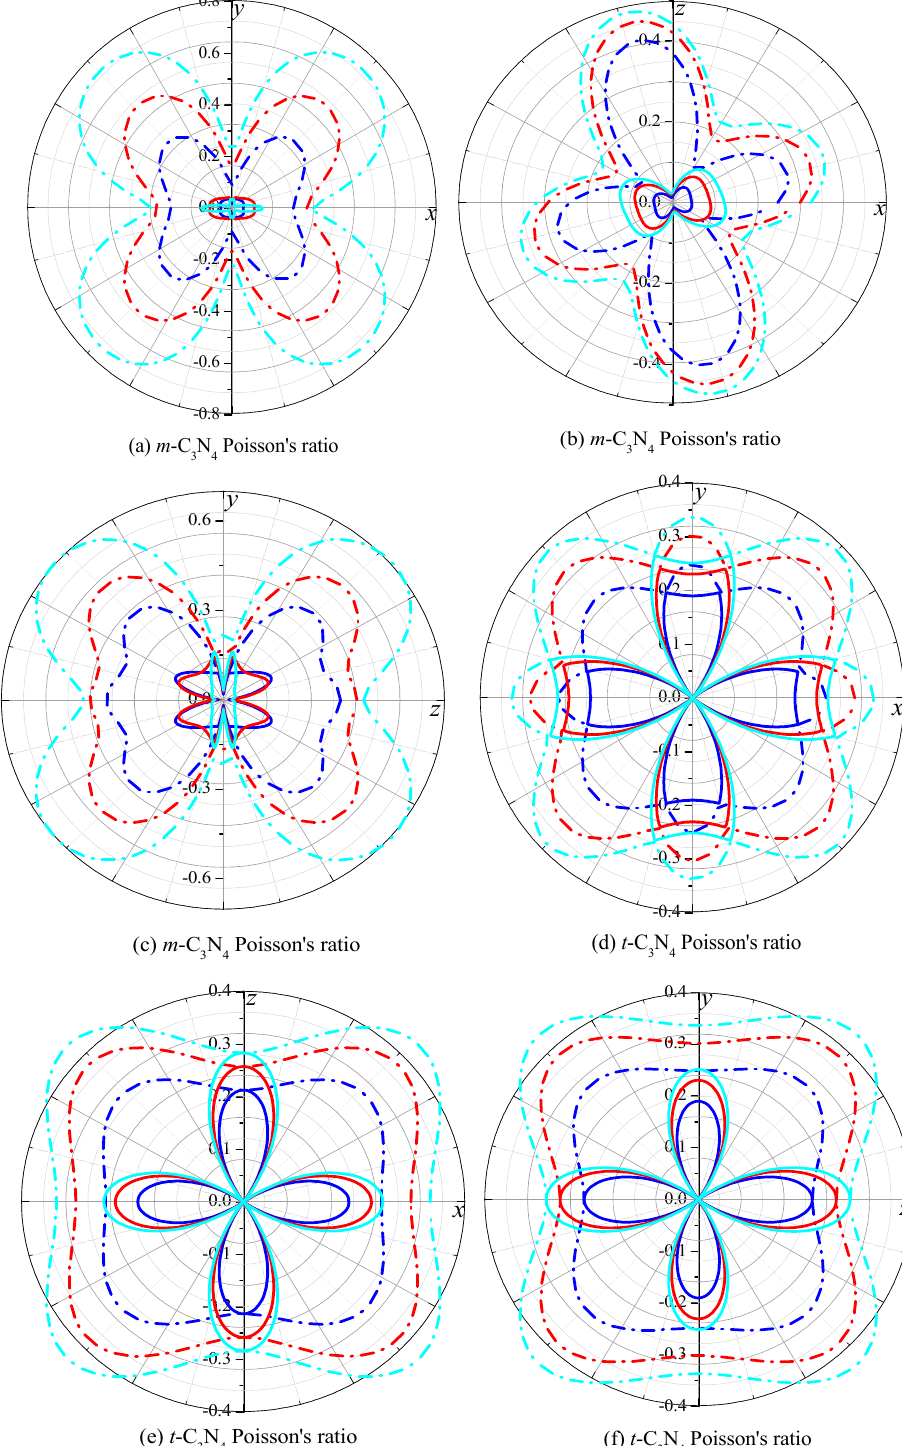
Figure 6. 2D representation of Poisson’s ratio in the xy plane, xz plane and yz plane for: m -C 3 N 4 ( a – c ); and t -C 3 N 4 ( d – f ). The solid line represents the minimum, and the dashed line represents the maximum. The blue, red and cyan lines represent Poisson’s ratio at p = 0, 50 and 100 GPa, respectively.